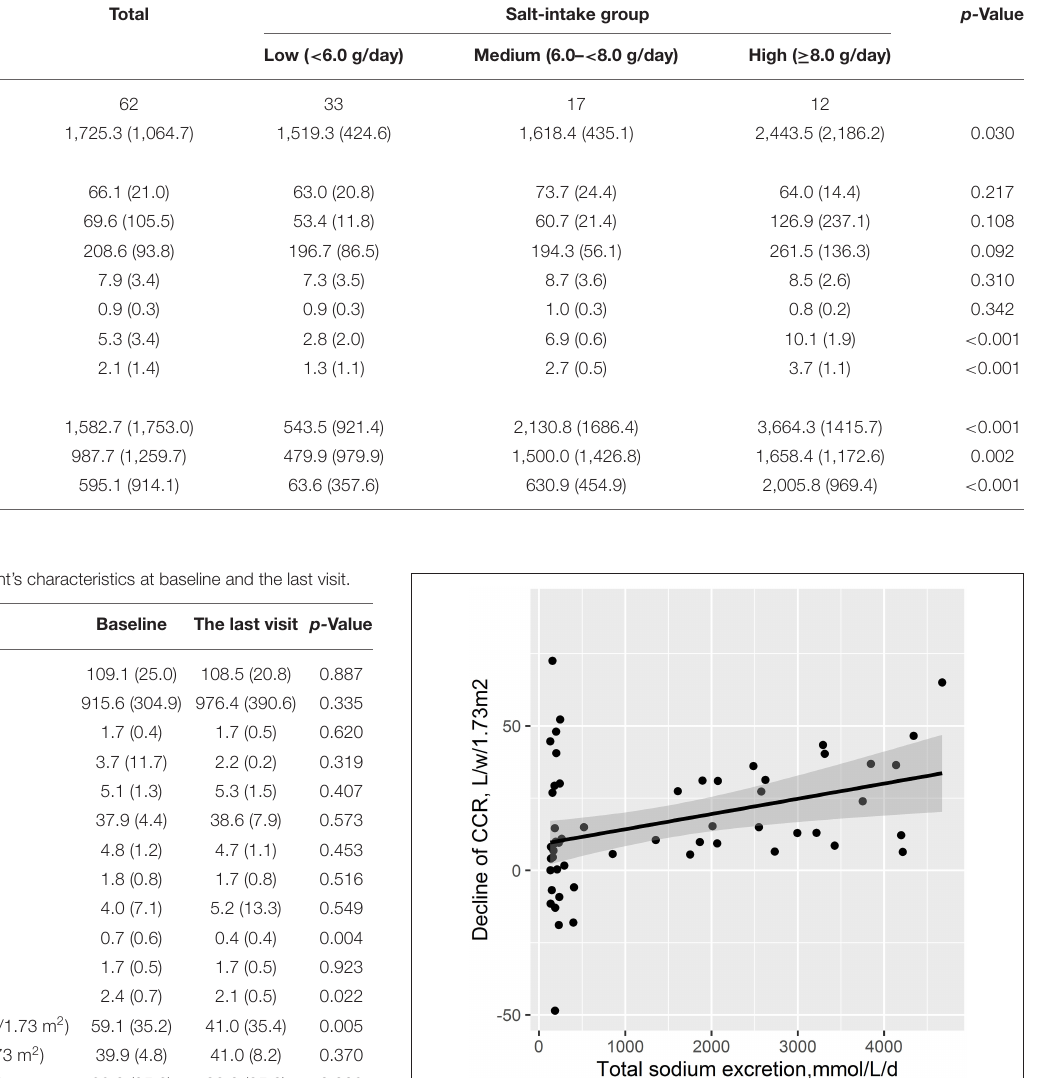
TABLE 2 | The dietary intake and sodium excretion in PD patients. Variable